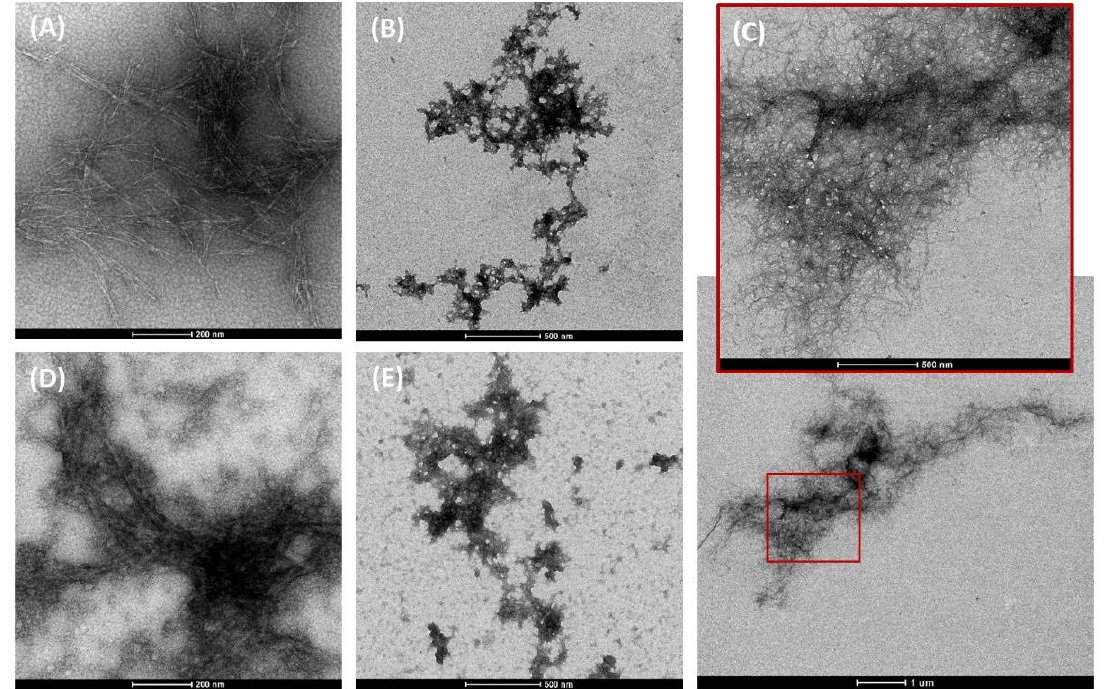
Figure 2. TEM images of the three cellulose micro/nanomaterials under study dispersed in PBS ( A – C ) or in complete culture medium ( D , E ). ( A , D ) CNC; ( B , E ) CMF-ENZ; ( C ) CNF-TEMPO.